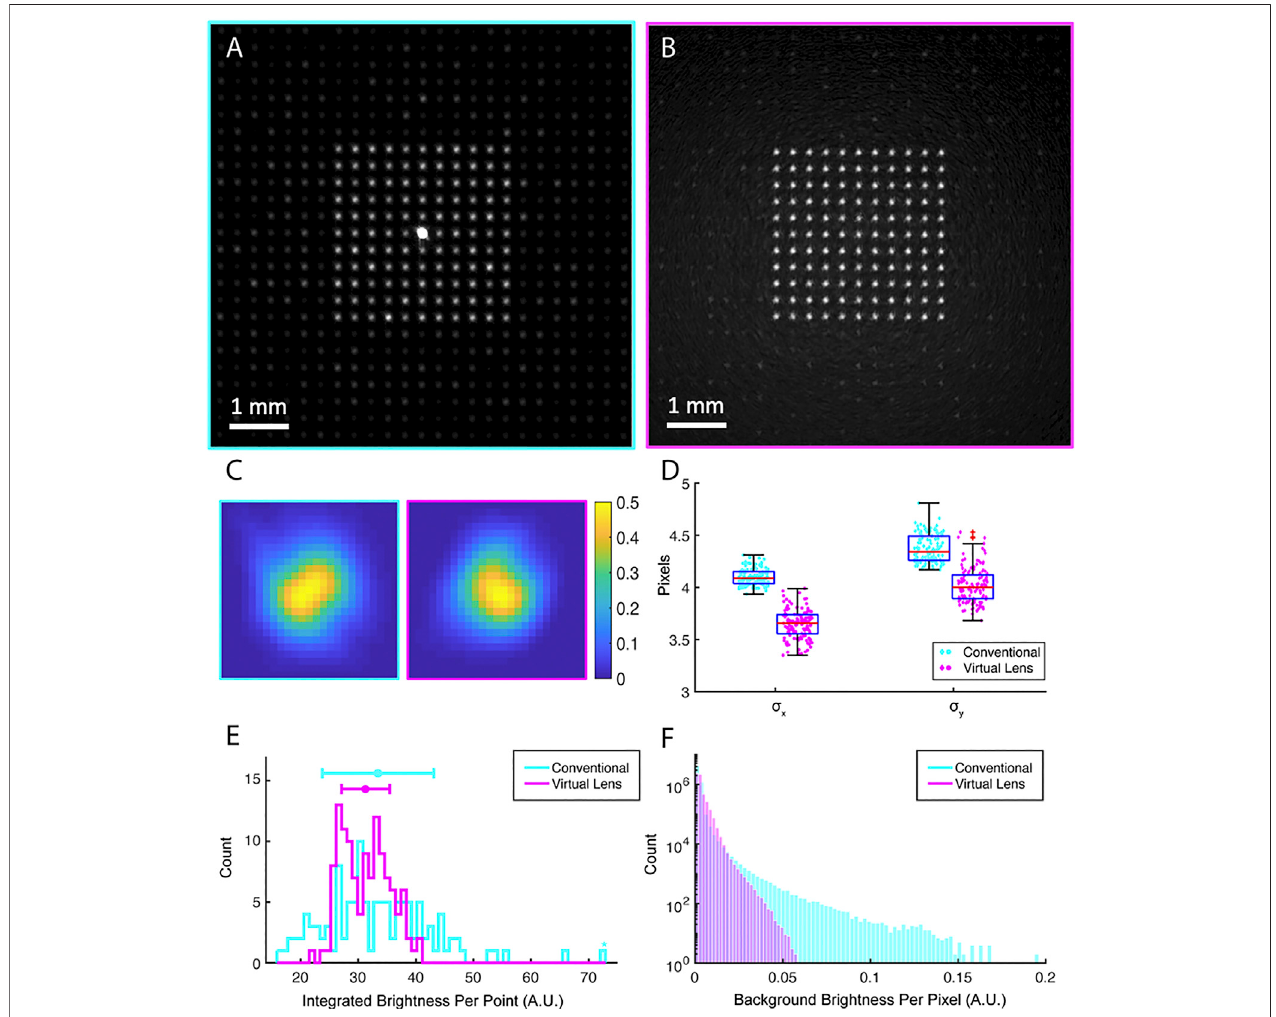
FIGURE 4 | Quanti fi cation of the fi delity of reconstruction of an array of points by the conventional and virtual paths (A) The intensity pattern generated at the object plane in an array of eleven-by-eleven points captured by the camera in the conventional beam path and (B) the virtual lens beam path. (C) The averaged intensity heat map ofthe SLM generated points created in theconventional (right) and the virtuallens beam path (left). (D) The distribution of standard deviation for a fi tted 2D Gaussian to each of the generated points in their orthogonal axes. (E) The integrated intensity distribution of the generated points in the conventional beam path and the virtual lens beam path. (F) Background intensity distribution (per pixel) for virtual lens beam path, and the conventional beam path excluding the 0 th order.